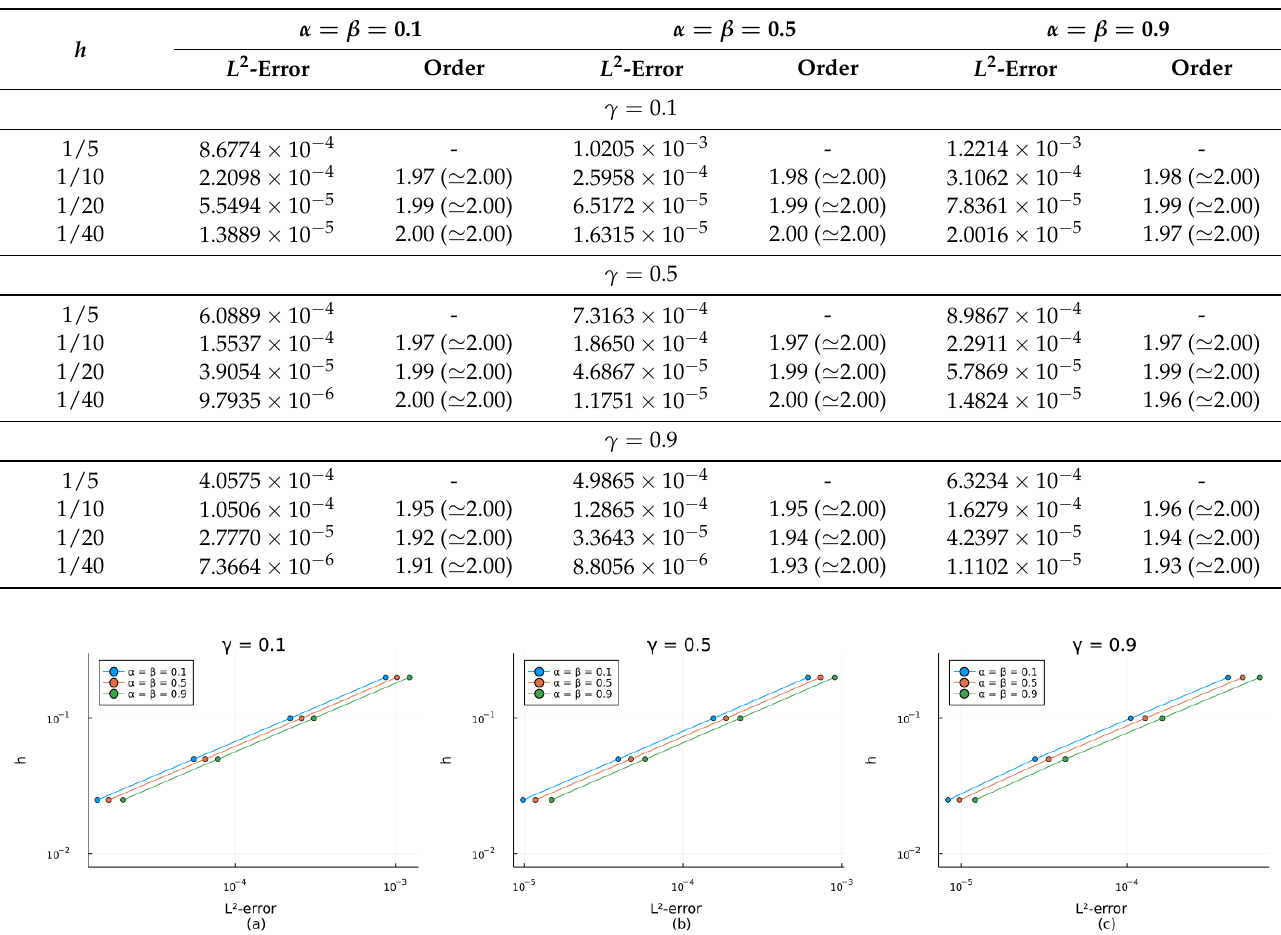
Table 2. L 2 -errors and convergence orders obtained for Example 1 when τ = 1/20,000. The numbers in parentheses indicate the theoretical convergence order.